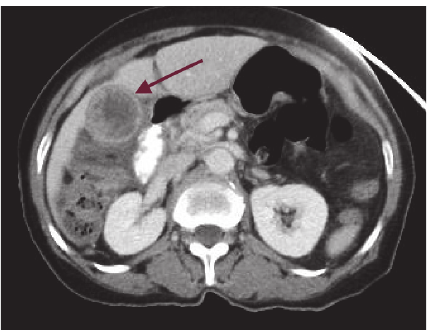
Figure 1: Abdominal CT showing irregular tissue mass in the gallbladder fundus (arrow).